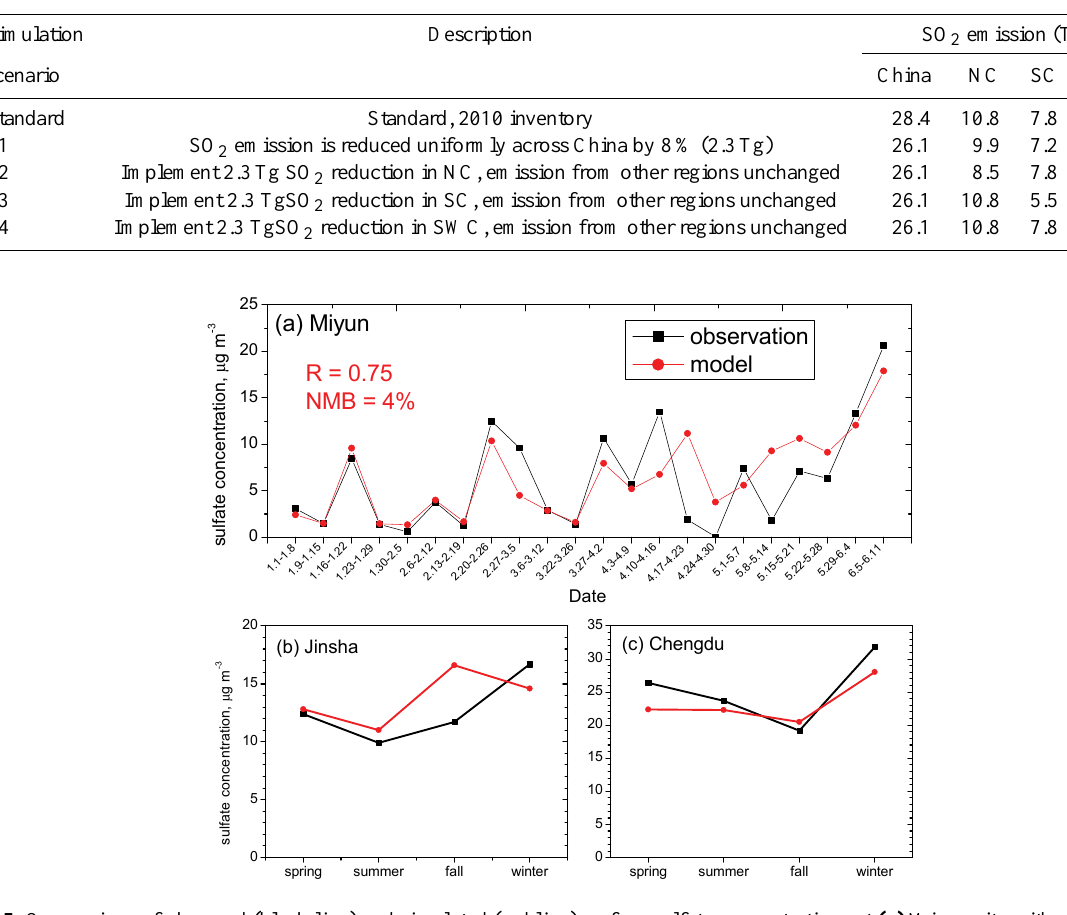
Table 1. Simulation scenarios and SO 2 emission in each study.